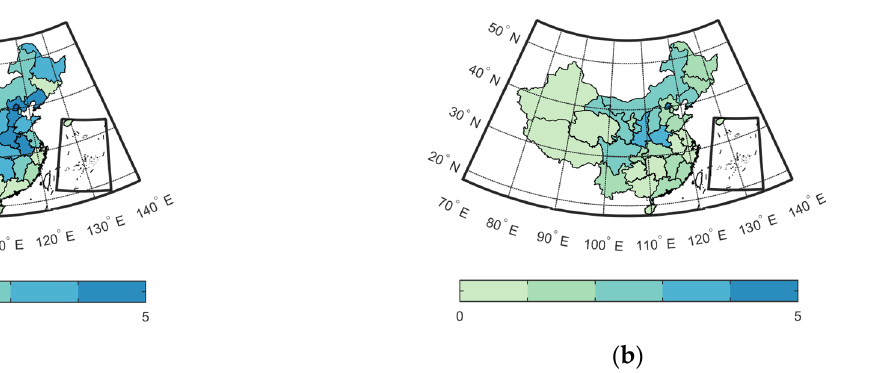
Figure 6. Number of years when correlations between PM 2.5 concentration and related Weibos were significant and positive for individual PARs for: ( a ) APR Weibos; ( b ) HR Weibos.